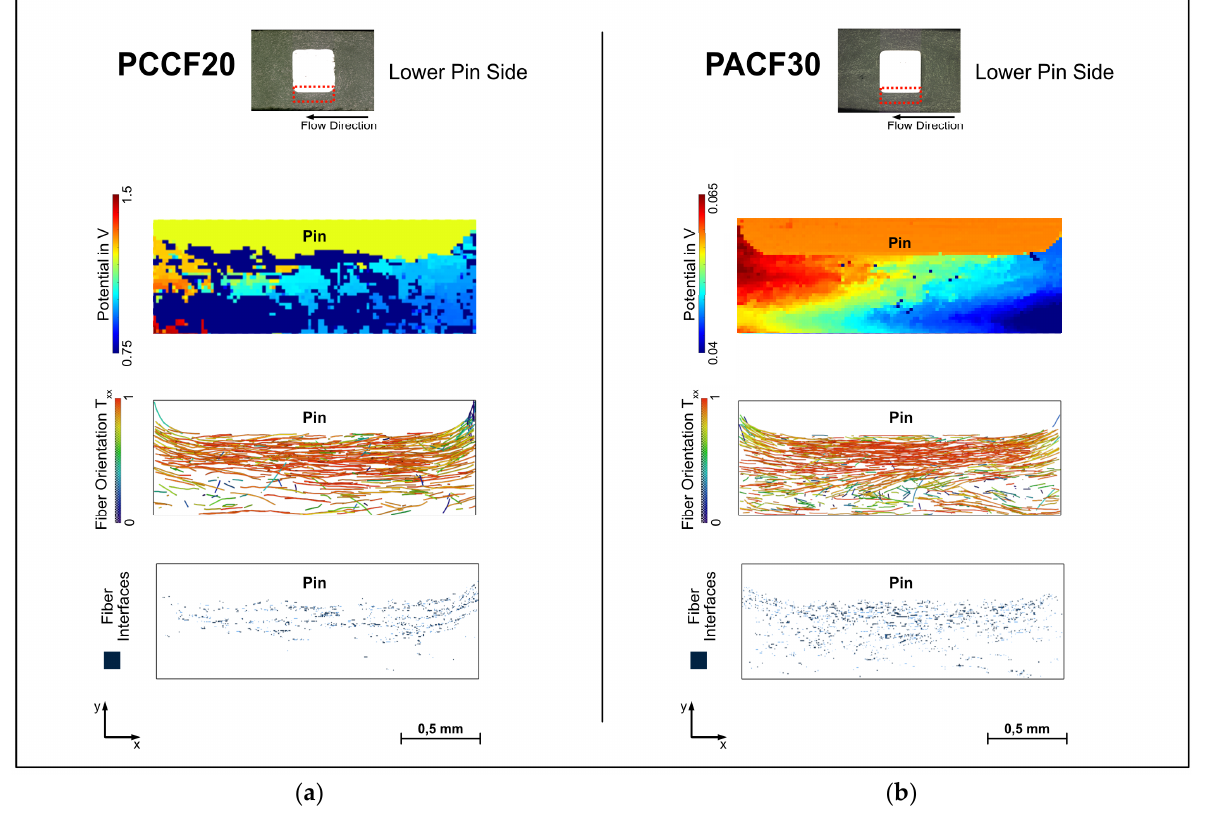
Figure 19. Comparison of the measured potential fields and the fiber orientation at the lower pin sides of the specimen PC CF20_4 mm ( a ) and PA CF30_5 mm ( b ).